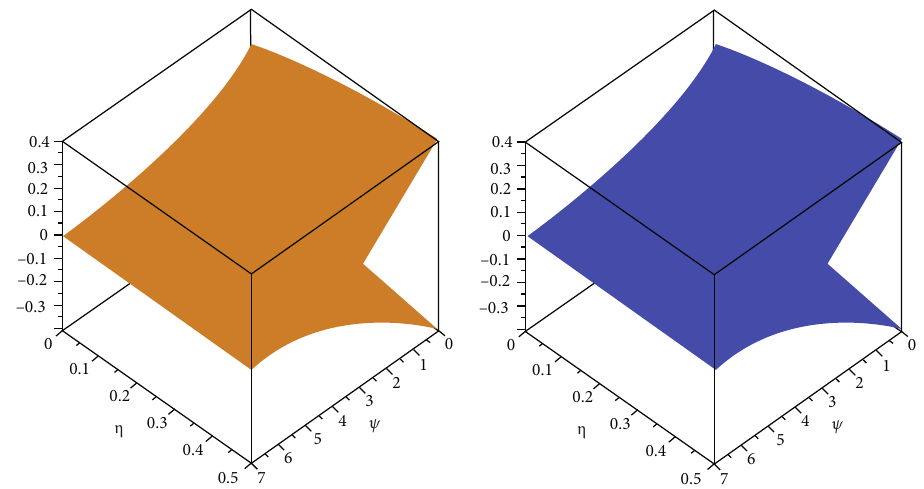
Figure 6: The fi rst graph shows the fuzzy 3D upper and lower fi gure of analytical solution at γ = 0 : 6 and the second graph at fractional of γ = 0 : 4